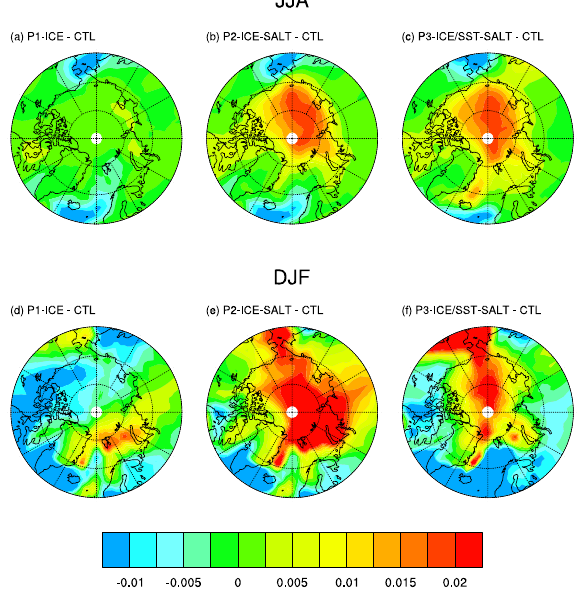
Fig. 11. Average summer (JJA) and winter (DJF) modeled differ- ence (relative to the CTL simulation) in the natural AOD in response to changes in sea ice